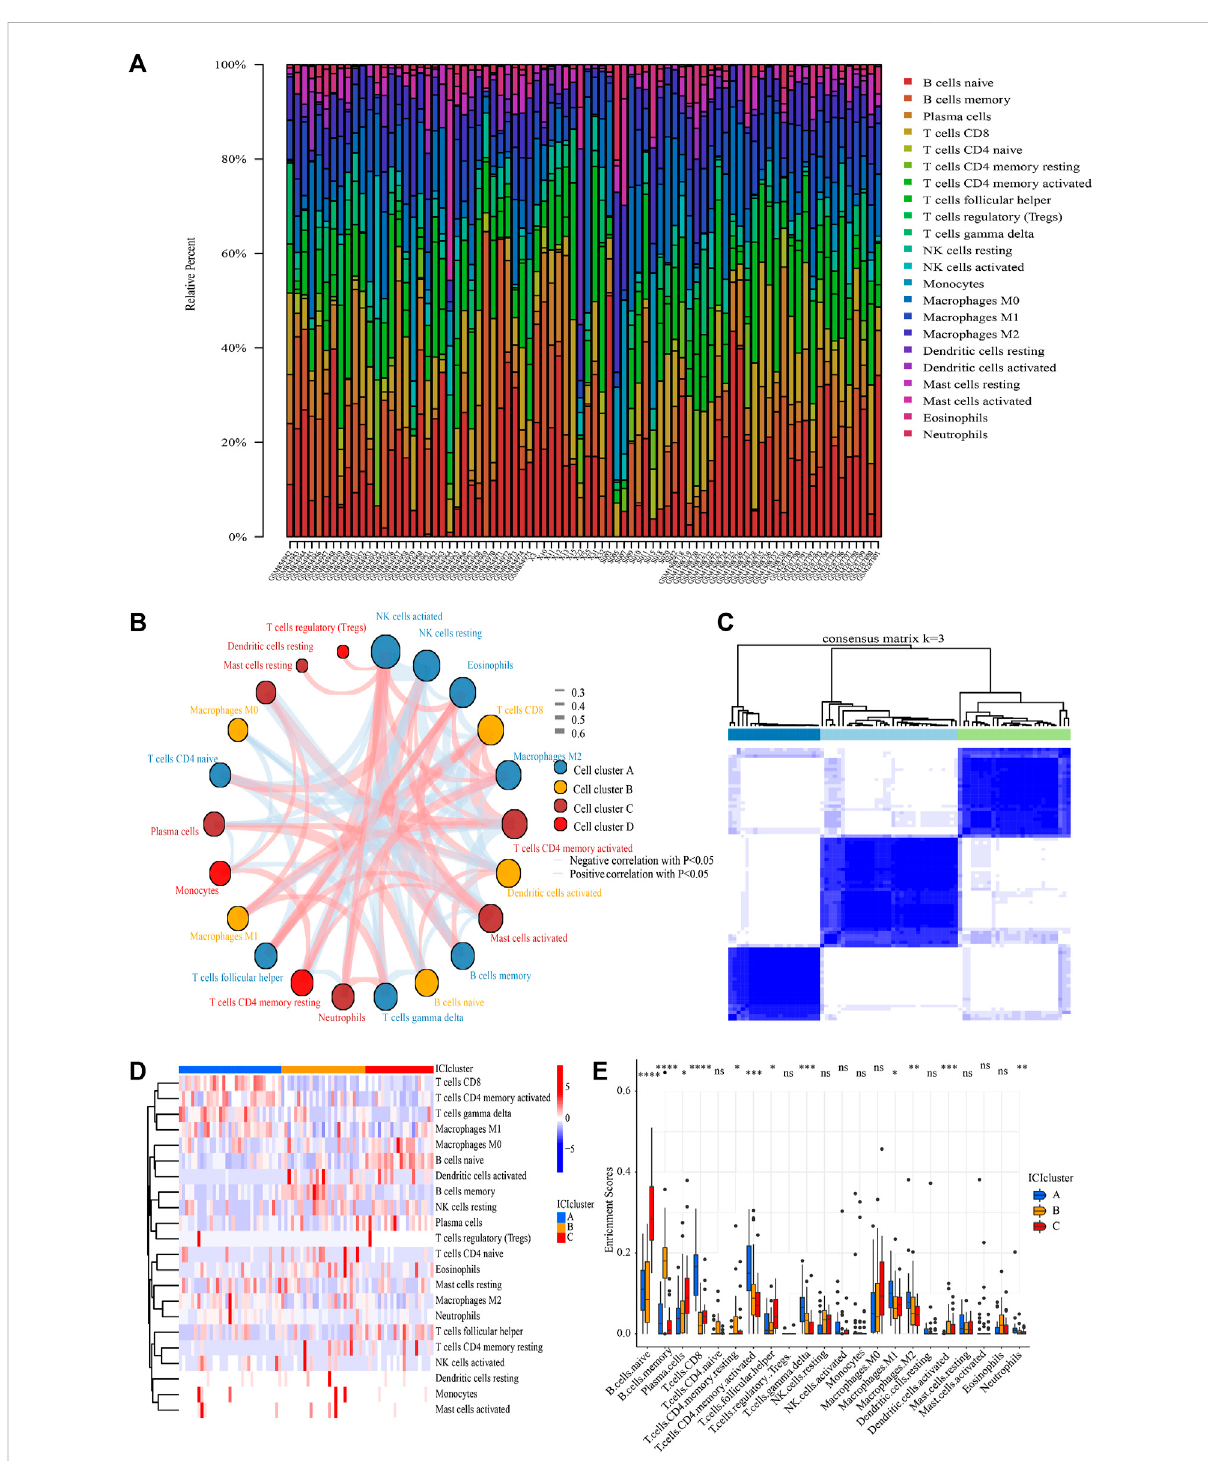
FIGURE 3 ICI analysis and sample clustering. (A) Relative proportions of 22 immune cell subpopulation in PCNSL samples. (B) Cellular interaction of 22 immune cell subpopulation. (C) Consensus matrixes of all PCNSL samples for appropriate k value ( k = 3). (D) The heat map showed unsupervised clustering of 22 immune cell subpopulation in all PCNSL samples (Rows represented tumor-in fi ltrating immune cells, and columns represented samples). (E) The fraction of tumor-in fi ltrating immune cells in three ICI clusters (The Kruskal – Wallis test was used to assess the statistical difference among three ICI